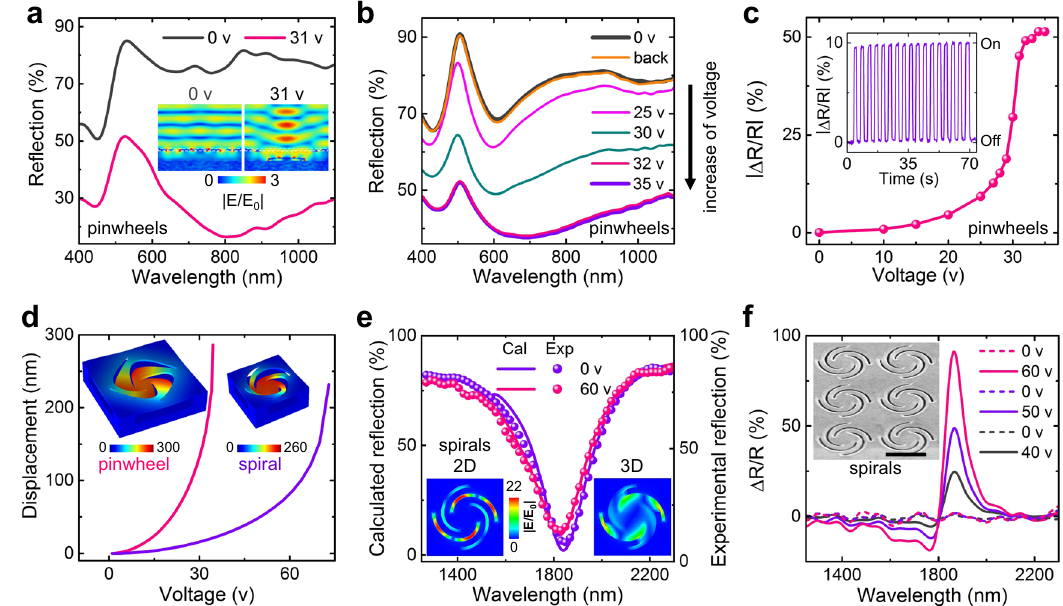
Fig. 3 Electromechanically recon fi gurable optical nano-kirigami. a Calculated and b experimental re fl ection spectra in normal direction for a pinwheel array under different DC voltages as noted. Inset, calculated electric fi eld distributions in the xz -plane ( y = 0) under V = 0 and 31 V (with Δ d = 300 nm and λ = 750 nm), respectively. Image size: 2.5 × 2 μ m 2 . The distorted wave shape at V = 31 V indicates the diffraction to other directions under deformations since λ (cid:3) w (see Supplementary Fig. 6a). In experiments, the re fl ection stops changing when V > 32 V and the spectrum increases back to the initial 0 V (cid:3) (cid:3) (cid:3) (cid:3) ) versus applied voltage at λ = 750 nm. Inset, condition after turning off the voltage at 35 V. c Amplitude of modulation contrast (de fi ned as Δ R = R modulation contrast versus time when the voltage is turned on and off at 20 V and λ = 550 nm. d Calculated vertical displacement ( Δ d ) versus applied voltage for a pinwheel and a type-i spiral, respectively, of which the pull-in voltages are identi fi ed at 35 and 73 V. Inset, simulated structures with corresponding maximum Δ d (units: nm). e Calculated (Cal) and experimental (Exp) re fl ection spectra of the type-i spirals in the inset of f under V = 0 and 60 V (with Δ d = 70 nm), respectively. Inset, electric fi eld distributions of the 2D and 3D spirals in xy -plane ( z = 0) at λ = 1842 nm. Image size: 1.5 × 1.5 μ m 2 . f Modulation contrast versus wavelength when the DC voltage varies with a sequence 40 → 0 → 50 → 0 → 60 → 0 V (from bottom to top). Structural parameters: w = 2 µ m, p = 2.5 µ m, d = 300 nm for pinwheels; w = 1.225 µ m, p = 1.5 µ m, d = 300 nm for spirals. Scale bar: 1 µ